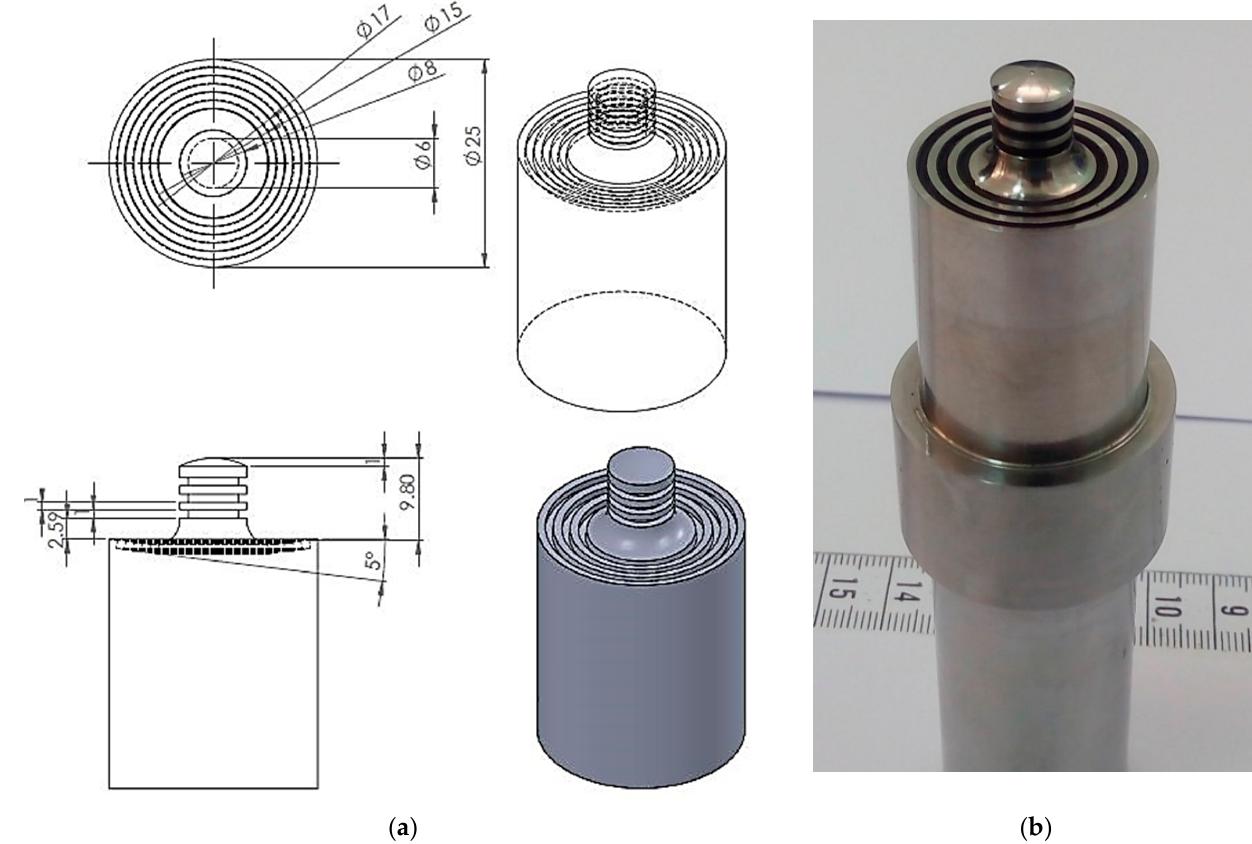
Figure 1. Friction stir welding (FSW) tool used in the FSW experiments ( a ) Computer aided design (CAD) drawings with detailed dimensions in mm and ( b ) image of the used FSW tool.